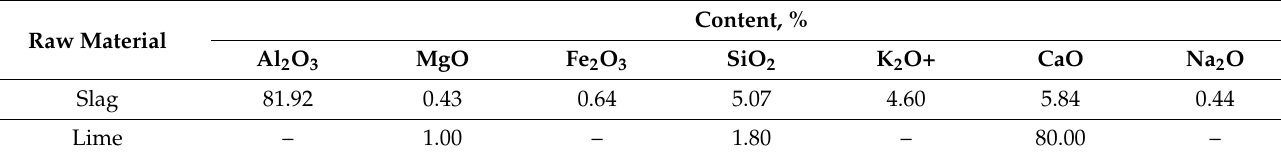
Table 11. Composition of starting materials.